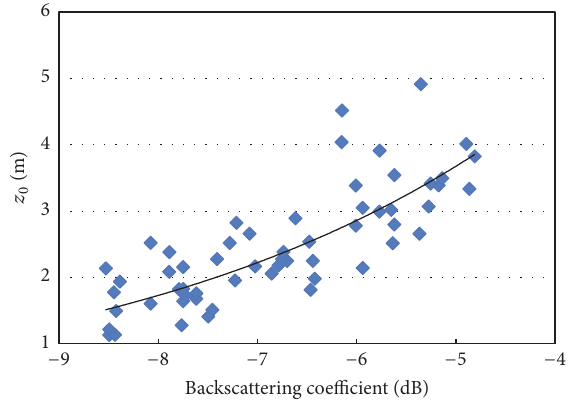
Figure 9: A scatter plot between the backscattering coefficient extracted from the upwind sector of radius 2500 m and 30 ∘ opening angle in ALOS PALSAR data and the ground truth aerodynamic roughness length.